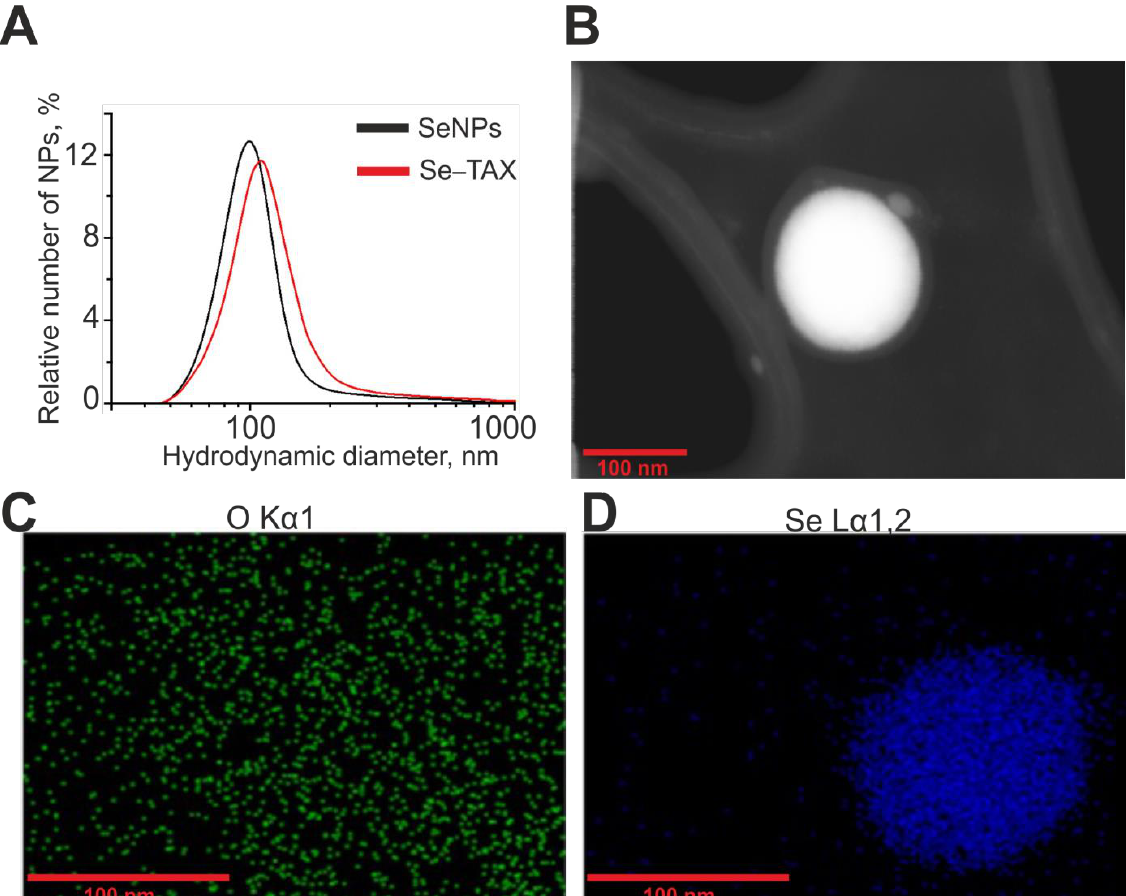
Figure 1. Shape, chemical composition, and size distribution of SeNPs and Se – TAX. ( A ) Size distribution of SeNPs (black) and Se – TAX. Data obtained using an analytical disk centrifuge and confirmed by DLS. ( B ) TEM image of an individual SeNP with a diameter of about 100 nm. ( C ) The distribution of oxygen atoms in panel B. ( D ) The distribution of selenium atoms in panel B.